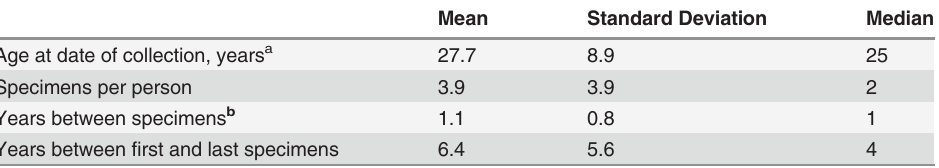
Years between fi rst and last specimens a. The maximum legal age for service members is between 17 and 62 years with few exceptions, so only those who were 17 – 70 years of age were included. Outliers were dropped. b. A total of 4,642,870 individuals provided only 1 specimen.